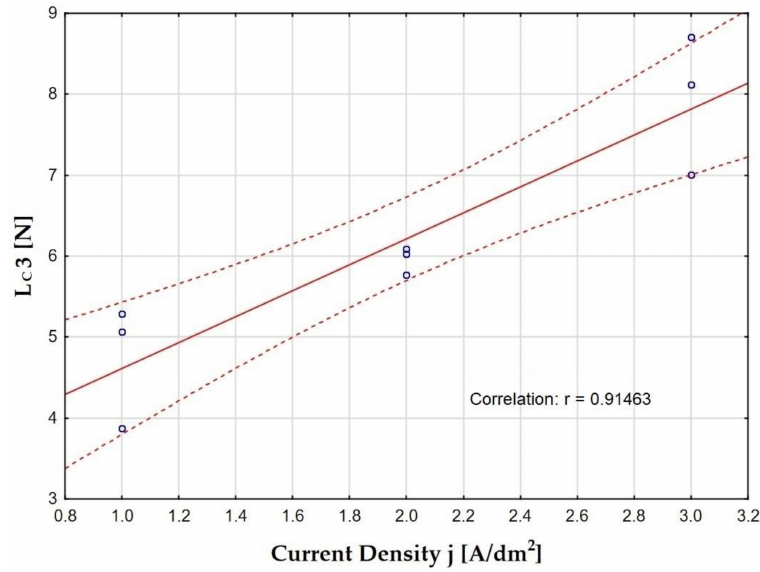
Figure 10. Effect of current density on Lc3, along with the confidence